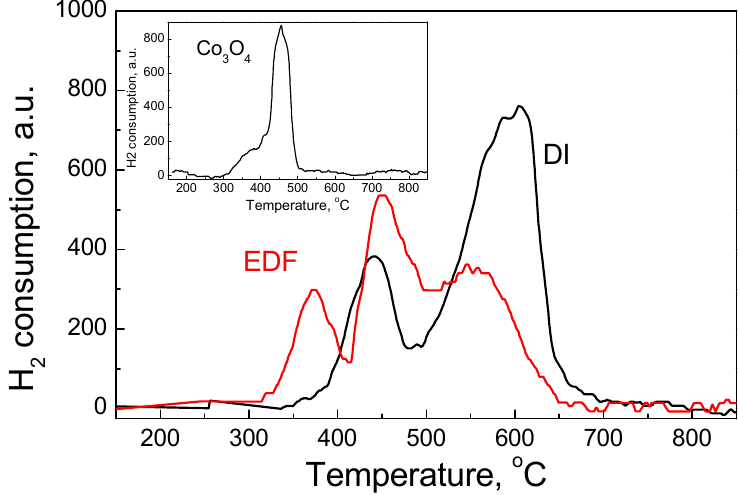
Figure 7. Temperature-programmed reduction (TPR) profiles for the samples studied, inset: the TPR profile for Co 3 O 4 .